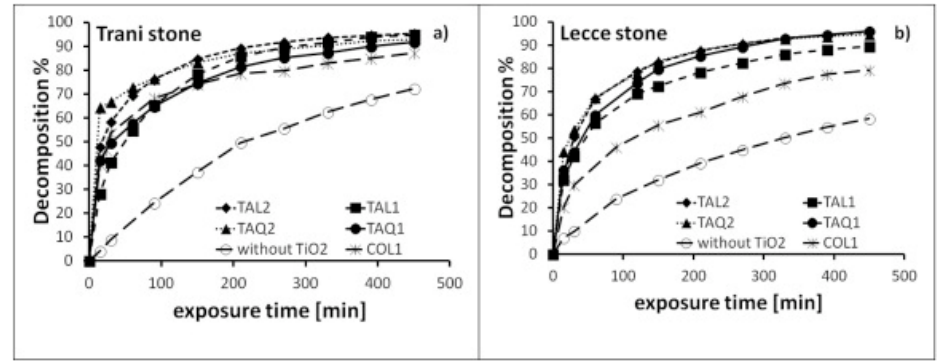
Figure 1. Decomposition rate of Rhodamine B for ( a ) Trani stone and ( b ) Lecce stone as a function of irradiation time [107]. (T: tetrapropylorthotitanate, AL: alcohol, and AQ: aqueous (water). TAL refers to a combination of T and AL in preparation condition, and TAQ refers to the combination of T and water.